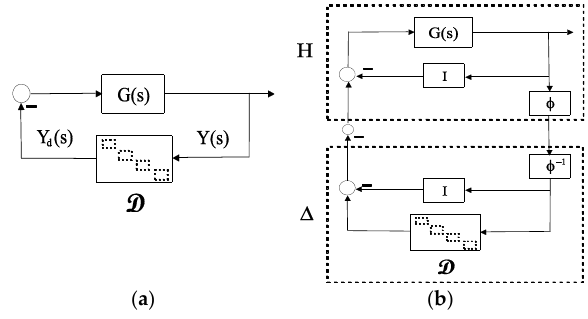
Figure 4. ( a ) LTI system with time-varying delay in the feedback loop; ( b ) Loop transformation.